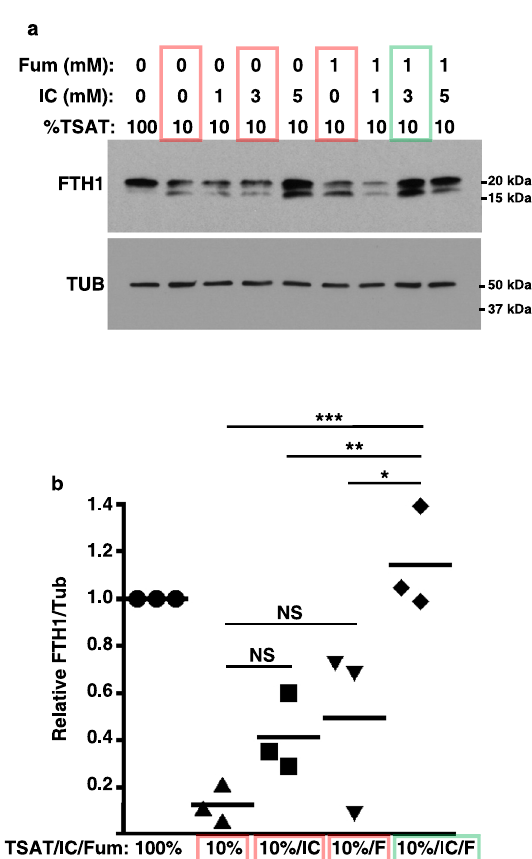
Fig. 5 Cooperative restoration of FTH1 by isocitrate and fumarate. a FTH1 levels by immunoblot on whole cell lysates from human CD34 + progenitors cultured 3 days in iron-replete (100% TSAT) or de fi cient (10% TSAT) erythroid medium ± 1 – 5mM isocitrate (IC) and ±1mM fumarate (Fum or F). Colored boxes highlight synergy of 3 mM IC with 1mM Fum. Red: iron restriction with no or single metabolite treatment; green: iron restriction with combined metabolite treatment. Representative results from three independent experiments. b Graph: mean normalized FTH1 signal (±3mM IC and ±1mM Fum), relative to value with 100% TSAT. Error bars, SEM; n = 3 biologically independent experiments; *, **, *** P = 0.02, 0.009, 0.0009, one-way ANOVA with Tukey post hoc. NS not signi fi cant. See also Supplementary Fig. 9. Source data are provided as a Source data fi